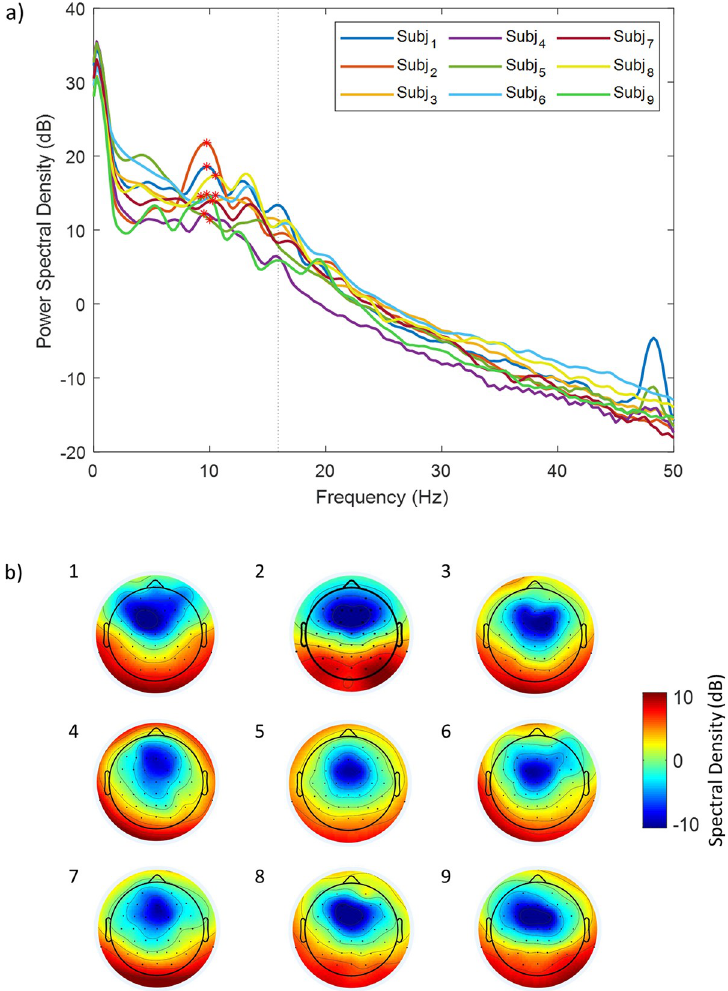
Fig 5. EEG log-power spectrogram and topographies during eyes-closed resting state for all human subjects during concurrent fMRI recordings with the MB sequence. (A) Power spectral density averaged across 8 posterior channels of each subject (O1, O2, Oz, PO3, PO4, PO7, PO8, POz). The stars denote the individual subjects’ maximum values within the alpha band (8–12 Hz) i.e. individual alpha peak. The dotted line represents the scanner artifact at 15.9 Hz. (B) Corresponding scalp topographies using all channels for the 9 subjects at the individual alpha peak frequency.